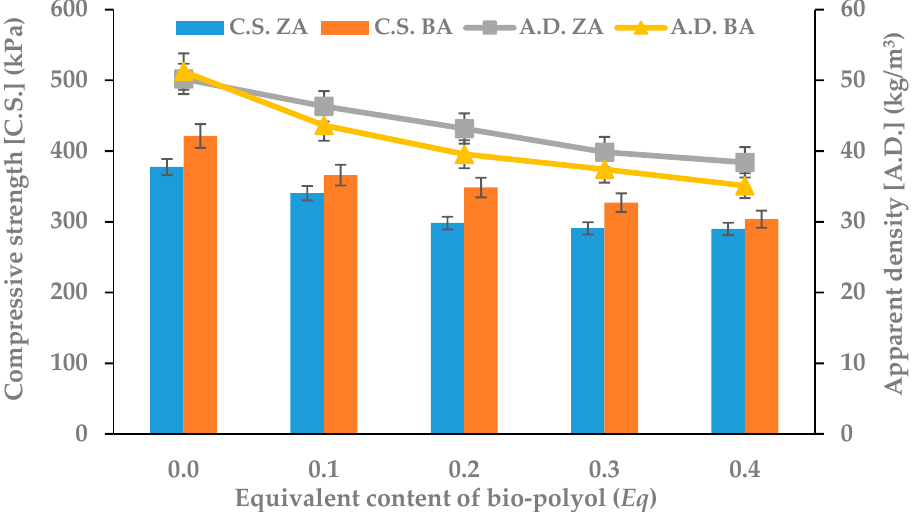
Figure 2. Dependence between bio-polyol content, compressive strength (C.S.) and apparent density (A.D.).